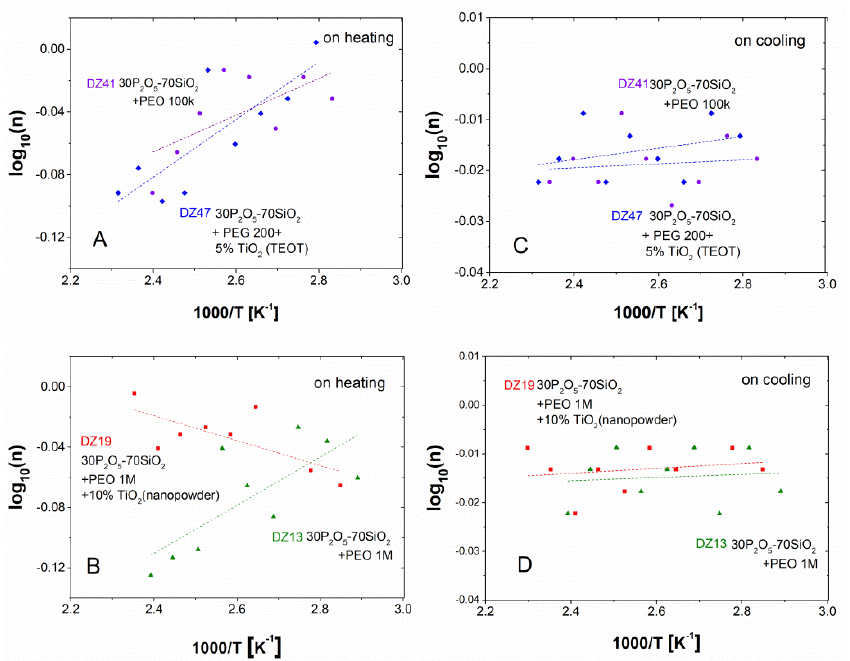
Figure 13. Jonscher’s log(n) vs. temperature dependencies with reference to dielectric relaxation data compiled for the investigated series, recorded during the heating sub-cycle of PEO-doped glass compositions: (cid:78) –DZ 13; • –DZ 41 (cid:4) –DZ 19 (cid:7) –DZ 47.